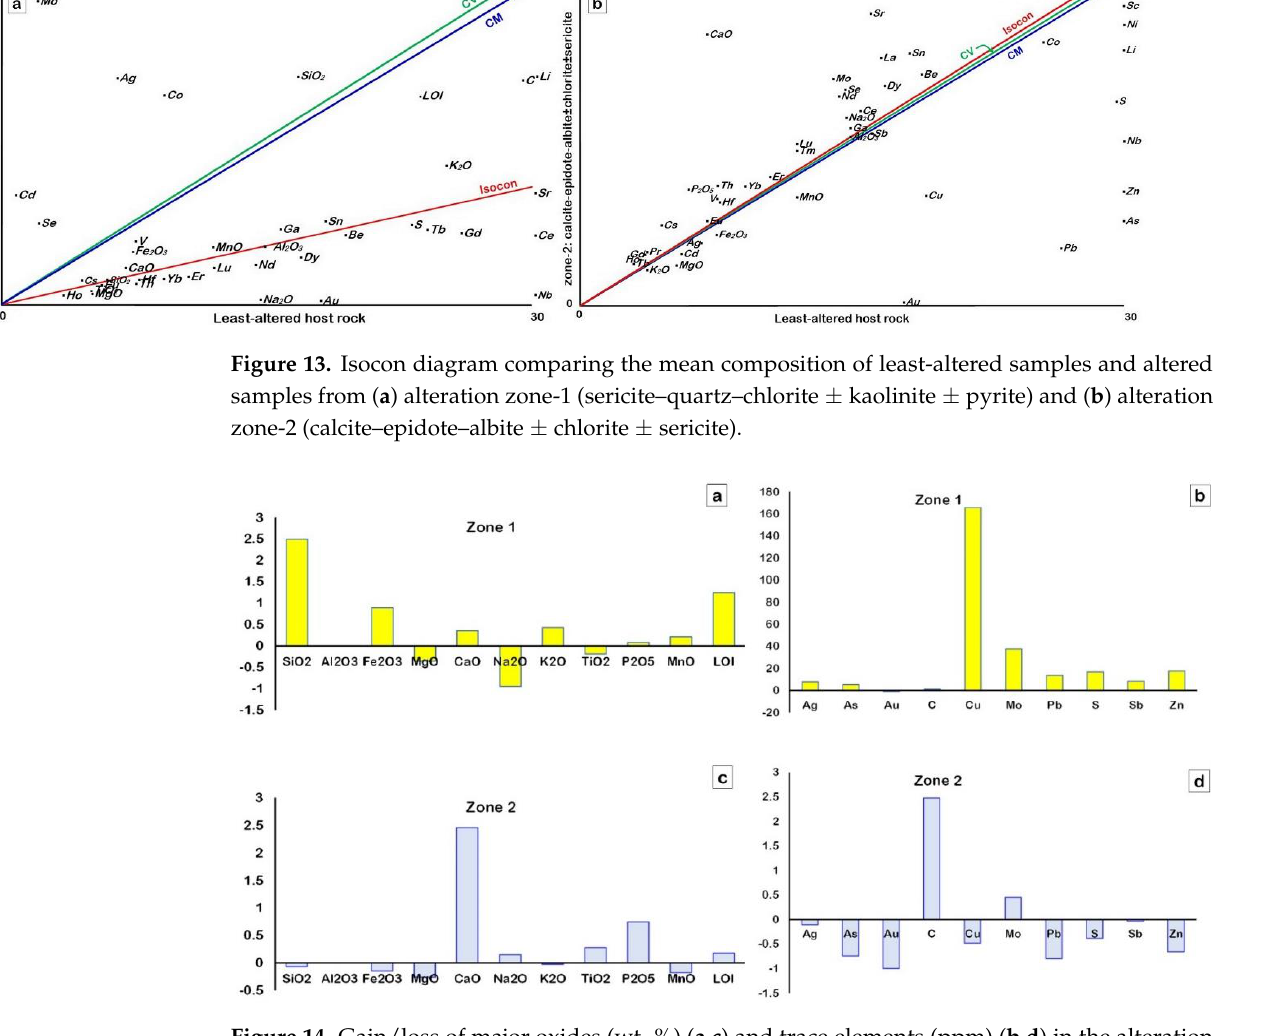
Figure 14. Gain/loss of major oxides (wt. %) ( a , c ) and trace elements (ppm) ( b , d ) in the alteration zones during hydrothermal alteration based on the mean data of the representative least − altered samples as a reference for